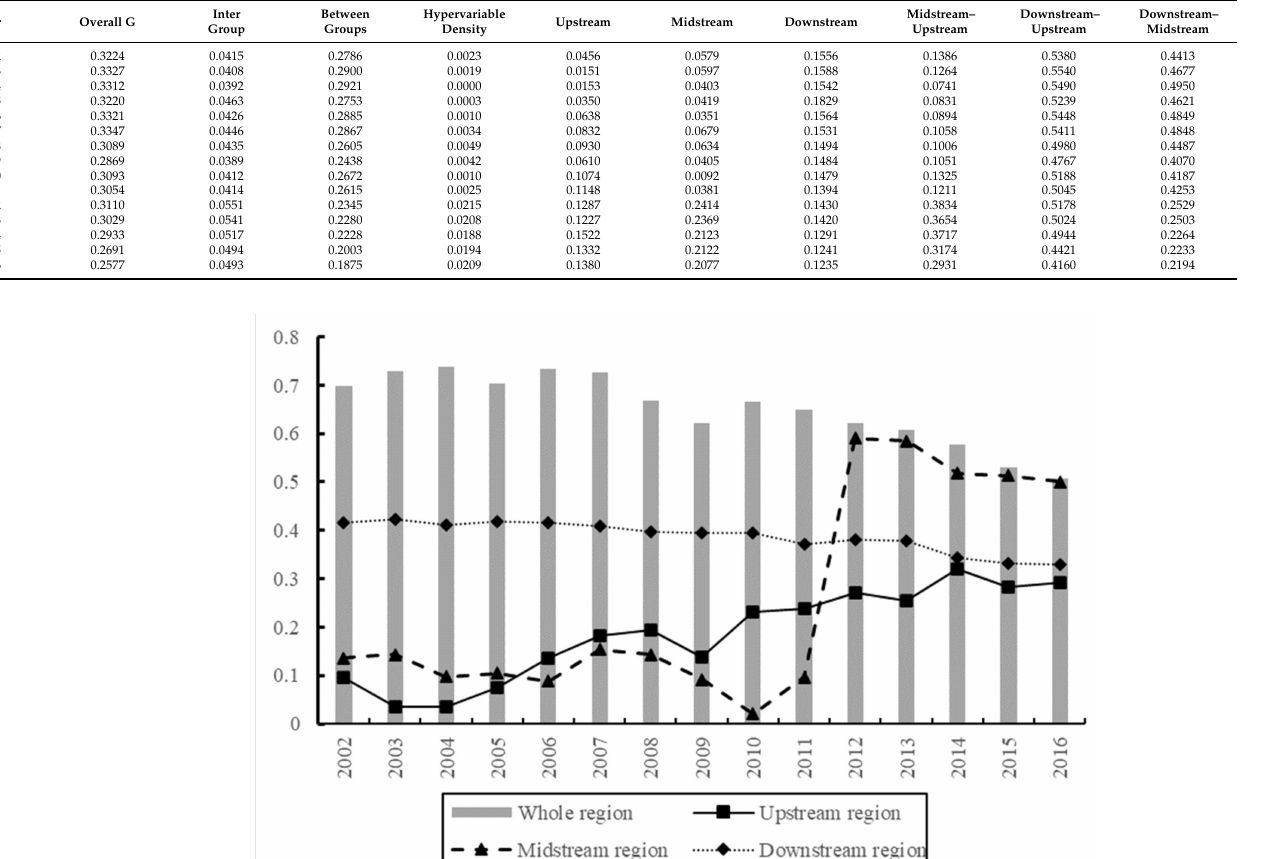
Figure 5. Absolute convergence